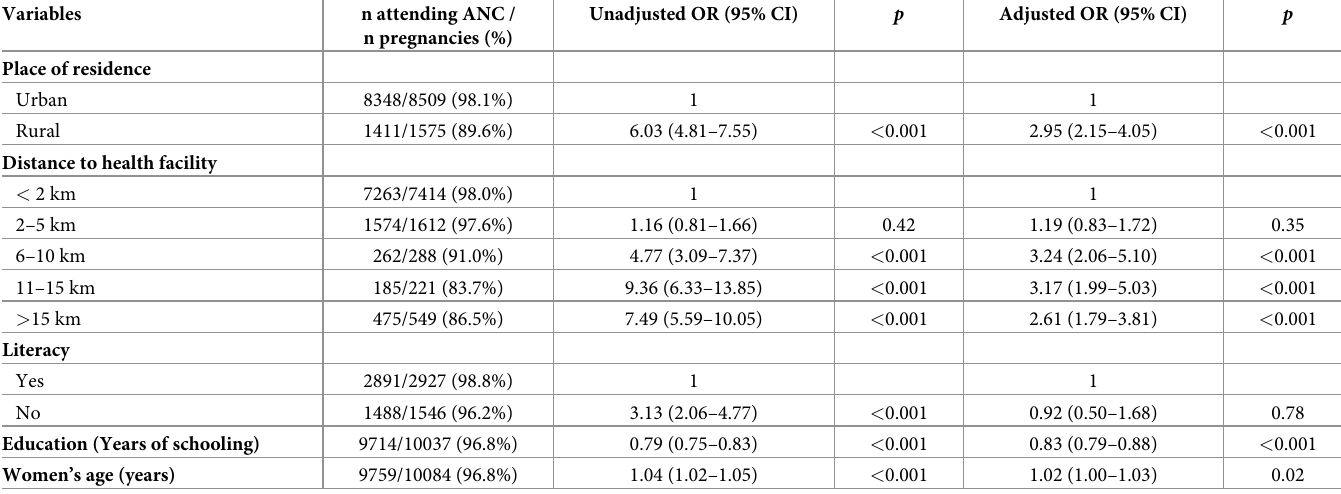
Table 4. Adjusted and unadjusted Odds Ratios (OR) of ANC attendance against predictor variables, from binomial logistic regression. Values of OR > 1 indicate increased risk of no ANC.